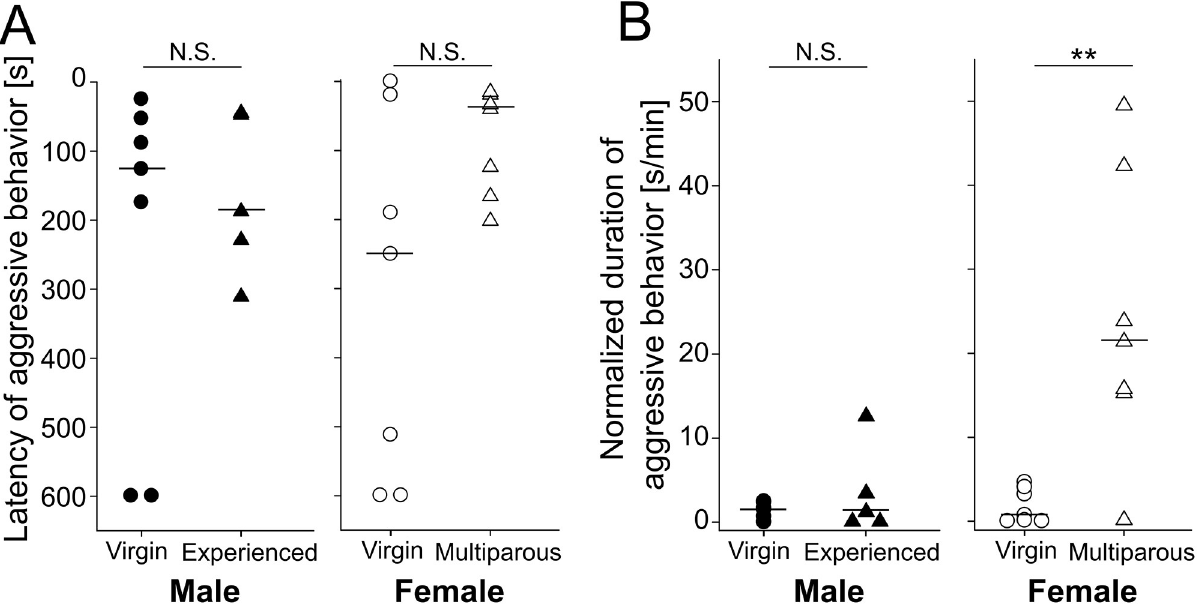
Fig 2. Latency of aggressive behavior and normalized duration of aggressive behavior of gerbil groups during resident-intruder tests. (A) latency of aggressive behavior in VM-VM, EM-VM, VF-VF, and MF-VF pairs. Thick horizontal bars represent medians. (B) normalized duration of aggressive behavior in VM-VM, EM-VM, VF-VF, and MF-VF pairs. Thick horizontal bars represent medians. ( ● , virgin male; ▲ , experienced male; ● , virgin female; ▲ , multiparous female). N.S.: Not significant, �� represents p <